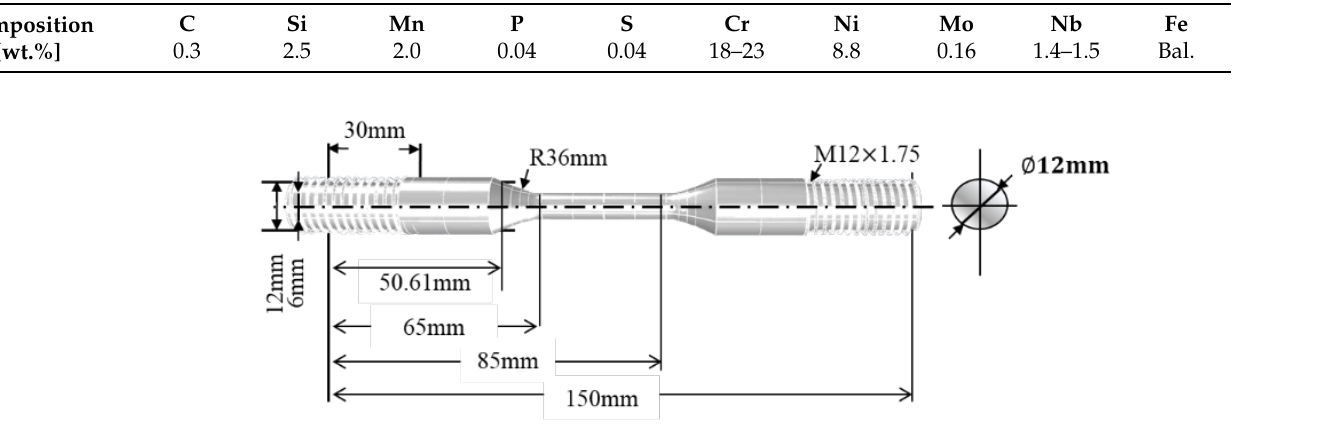
Figure 1. Specimen for the LCF test.